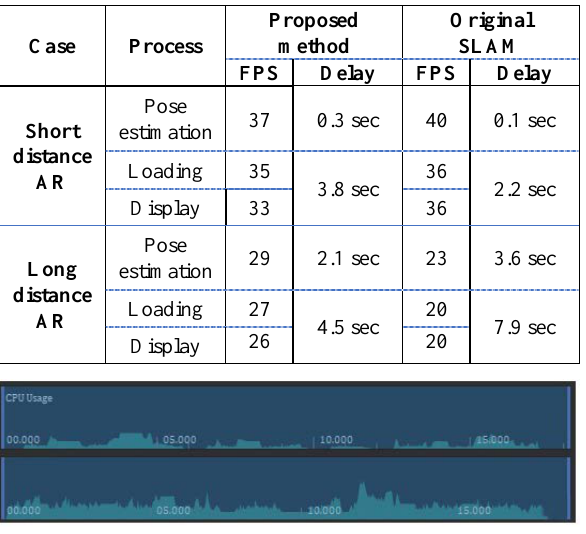
Figure 7. CPU usage comparison of our method (top) and original vSLAM (bottom), during a 15 sec AR